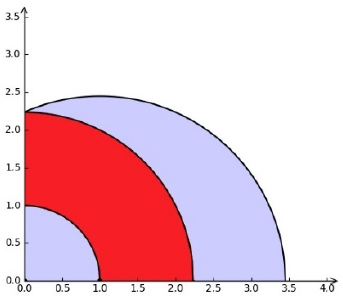
Figure 5. The mixture of Figures 3 and 4.